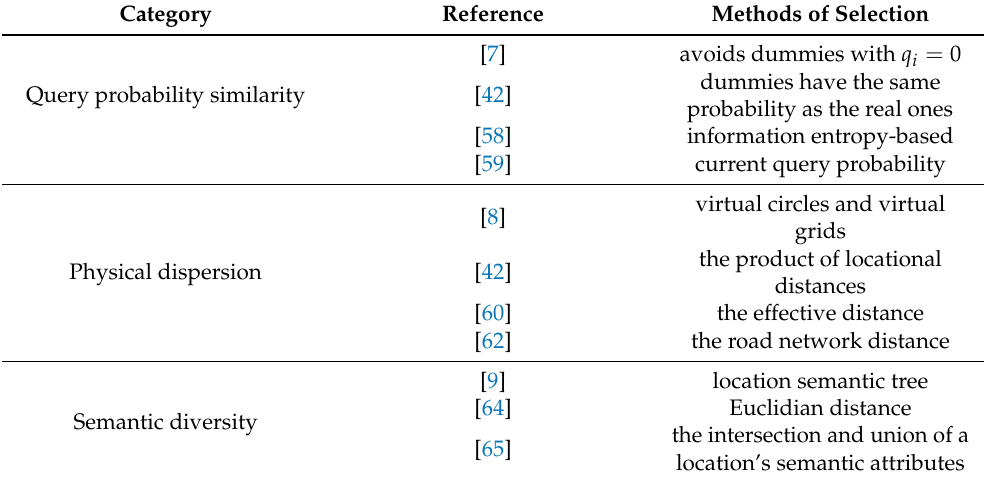
Table 3. Selection methods of dummy on query probability similarity, physical dispersion and semantic diversity. Category